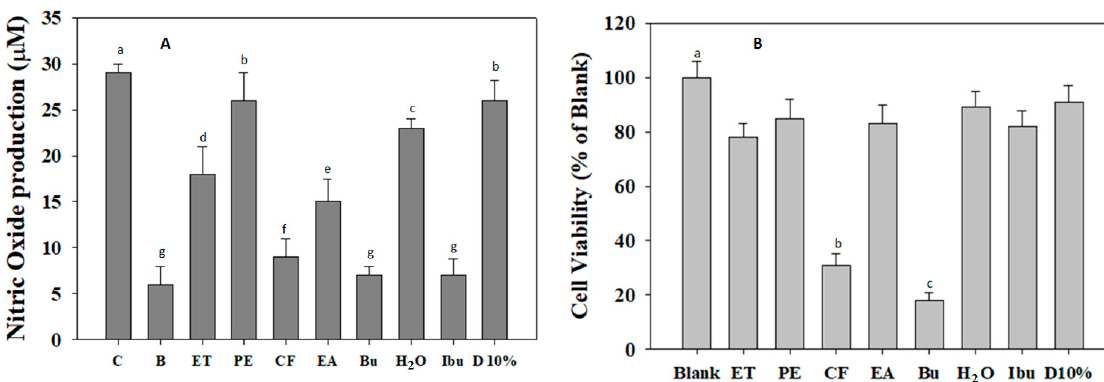
Figure 4. ( A ) The suppressive effect of wild bitter melon extract and fractions on nitric oxide (NO) production from LPS-stimulated RAW 264.7 cells. NO level was measured by the Griess reaction. Ibuprofen (Ibu) was used as positive control. DMSO 10% (D10%) was used as negative control. Control (C) was stimulated with LPS without the tested sample treatment, while blank (B) was free LPS and the tested sample. ( B ) The effect of wild bitter melon extract and fractions on RAW 264.7 cell viability. Blank is free the tested sample. DMSO 10% (D10%) was used as negative control. Cell viability was assessed by MTT method, and the results were expressed as percentage of surviving cells over blank cells. Each determination was made in three independent experiments, and the data were shown as means ± SD. Different letters a–g indicate significant difference among groups ( p < 0.05). Ethanol extract (ET), petroleum ether (PE), chloroform (CF), ethyl acetate (EA), n-butanol (Bu), and H 2 O fraction.